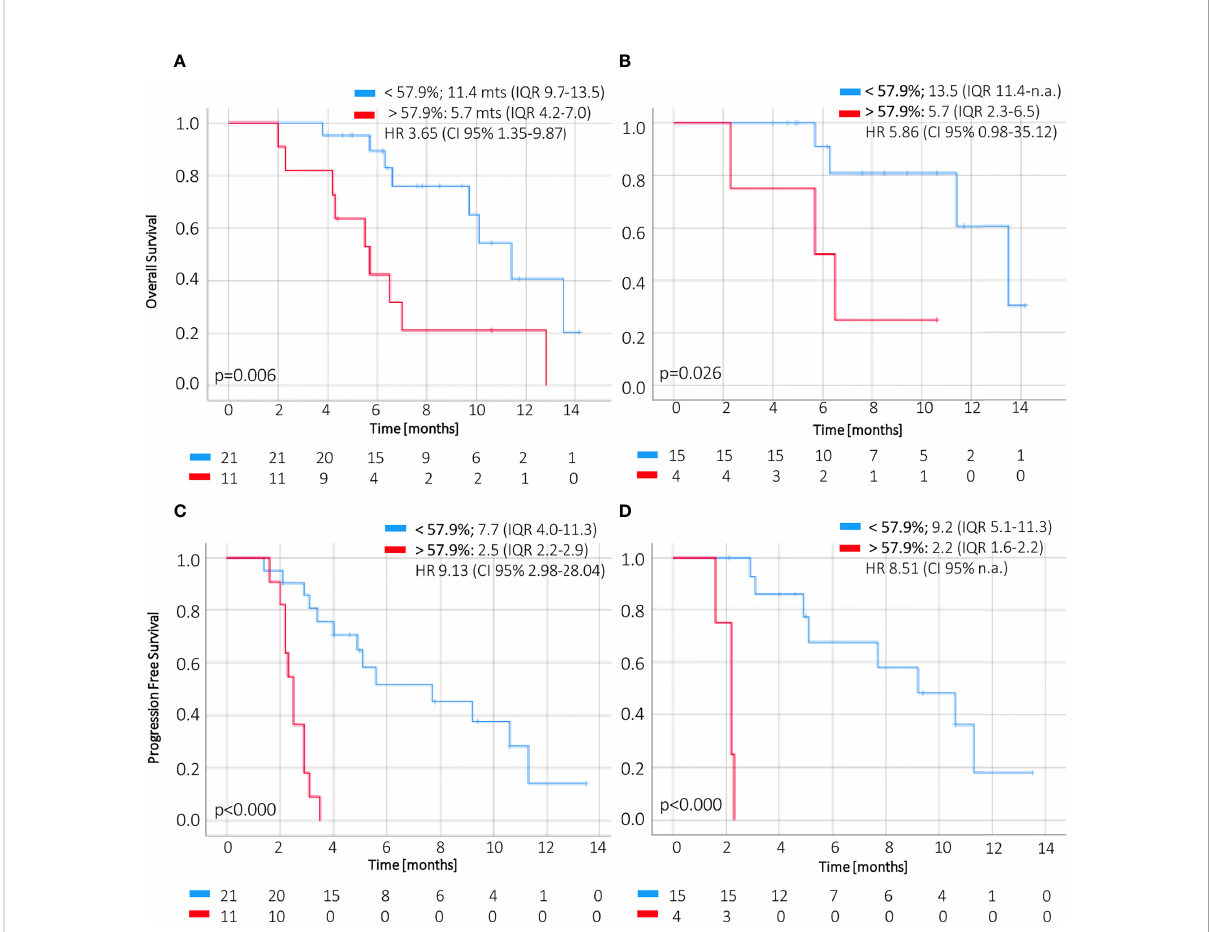
FIGURE 4 OS and PFS according to magnitude of ctDNA reduction at week 2. The change of ctDNA levels at 2 weeks of treatment below or above 57.9% (i.e., a reduction higher or less than 42.1%) of the baseline value correlates with overall survival (A, B) and progression – free survival (C, D) in ctDNA – positive patients. CI, con fi dence interval; HR, hazard ratio; IQR, interquartile range; OS, overall survival; PFS, progression – free